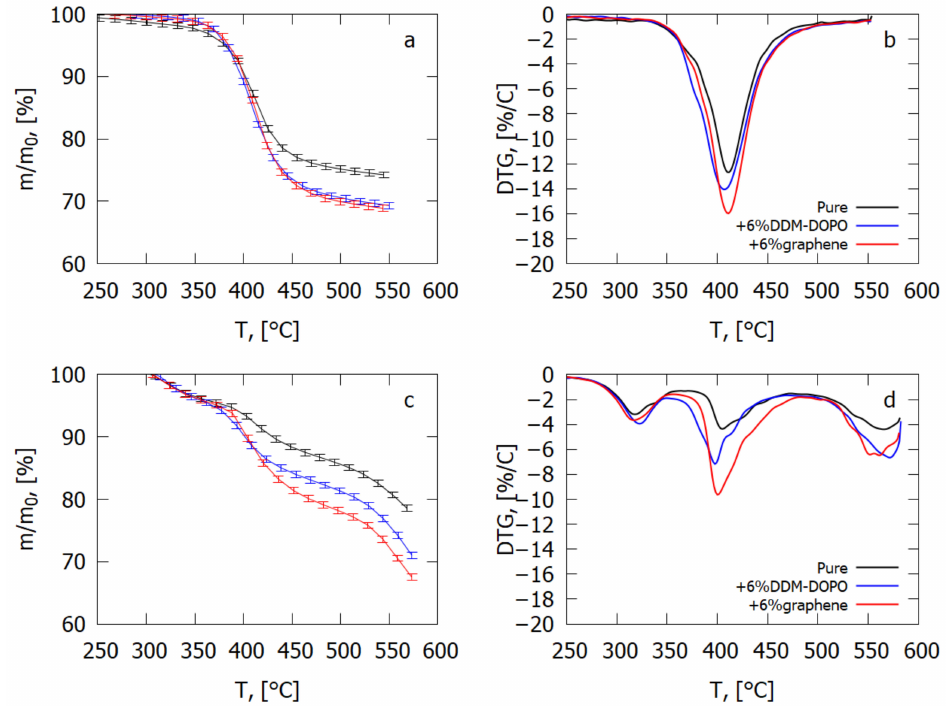
Figure 3. Thermogravimetric data of pure GFRER and GFRER composites. ( a ) TG in inert medium, ( b ) DTG in inert medium, ( c ) TG in air atmosphere and ( d ) DTG in air